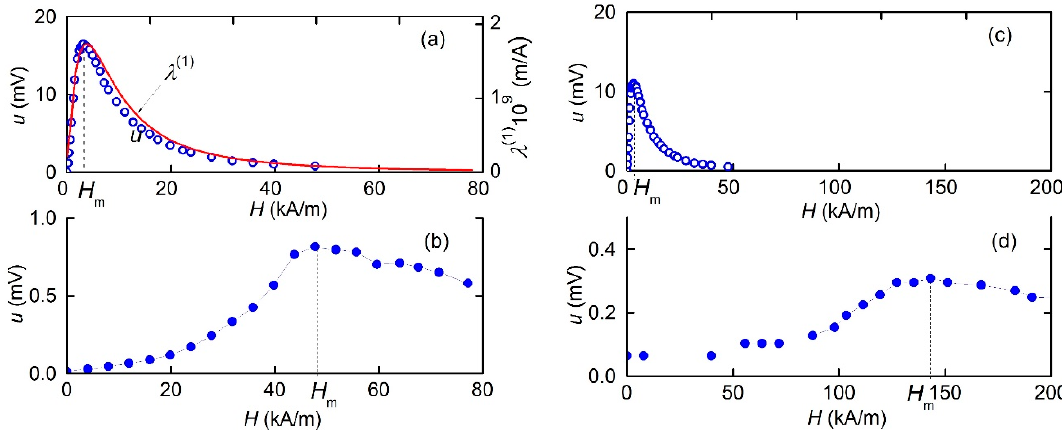
Figure 6. Dependence of the ME voltage u on the field magnitude H for the MFC-PZT structures with a period T 1 = 250 μ m ( a , b ) or T 2 = 500 μ m ( c , d ), magnetized either along ( a , c ) or across ( b , d ) the Ni-